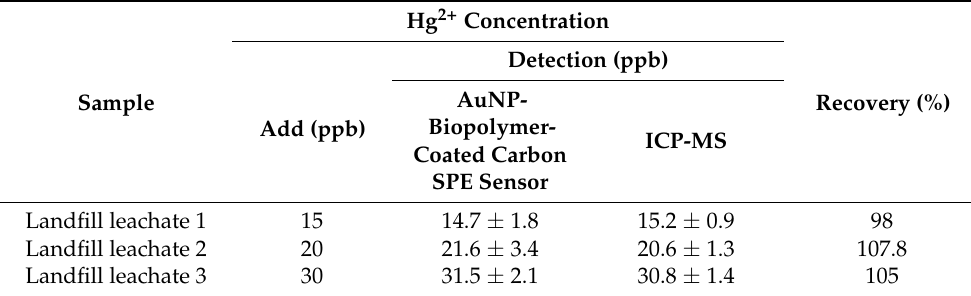
Table 2. Comparison of Hg 2+ detection methods between AuNP-biopolymer-coated carbon SPE sensor and ICP-MS (n =